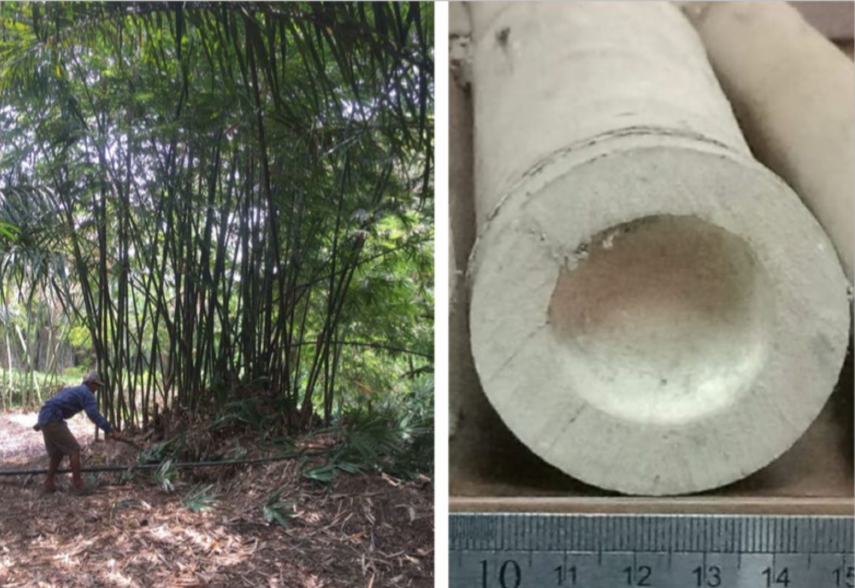
Figure 1. Bamboo clumps and bamboo middle culm cross-sections.